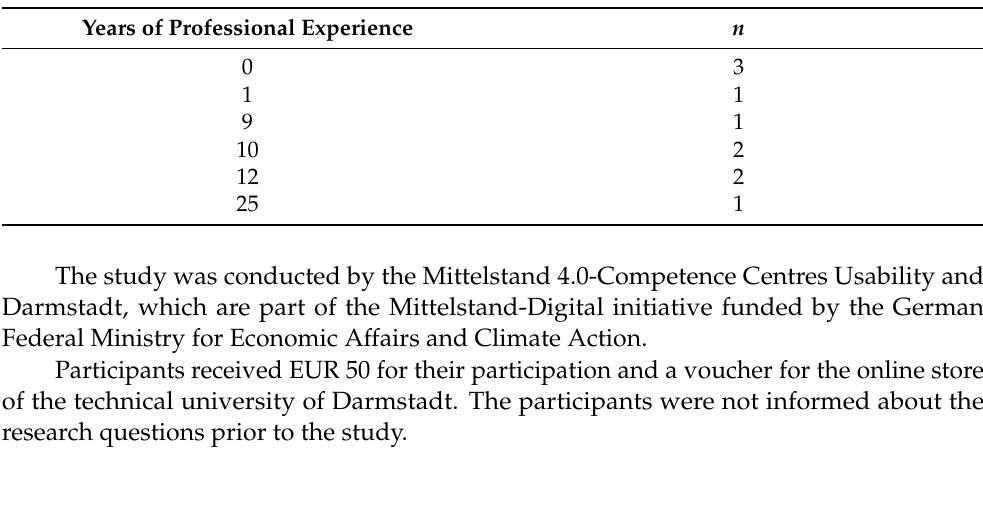
Table 8. Professional experience distribution among the